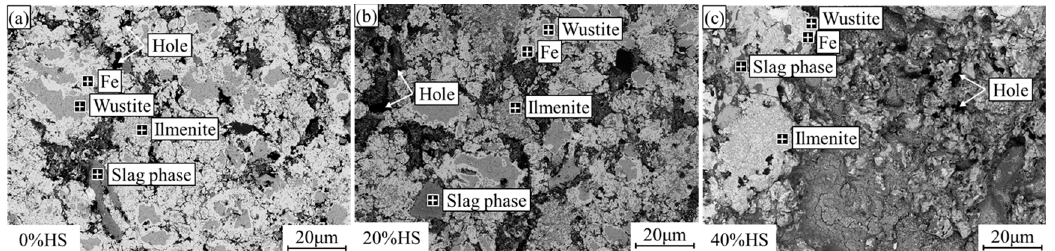
Figure 18. SEM diagrams of the oxidized pellets with the sea sand ore reduced at 900 °C for 3 h. ( a ) 0%HS; ( b ) 20%HS; ( c ) 40%HS.